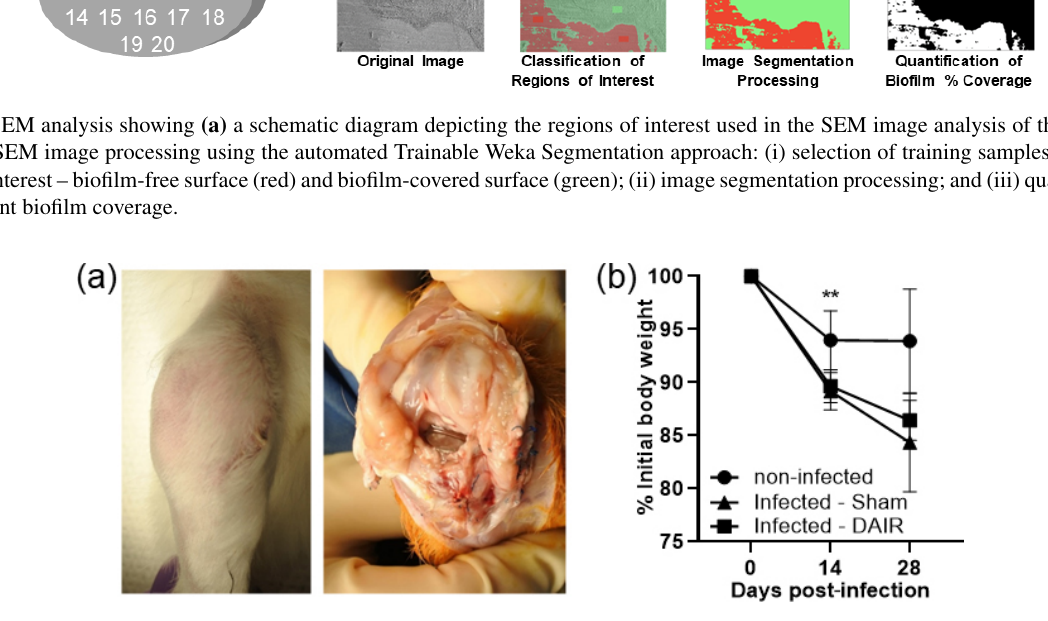
Figure 4. Gross findings and weight loss showing (a) representative gross images at 14d post-infection with 5 × 10 6 CFU of Xen36, and (b) the weight change in rabbits over time, plotted as the percent weight change from the initial weight. In panel (b) , n = 4 for the control treatment and n = 6 for infected treatments at 0d and 14d, and n = 3 for the control treatment and n = 6 for infected treatments at 28d ( ∗∗ p = 0.0023 at